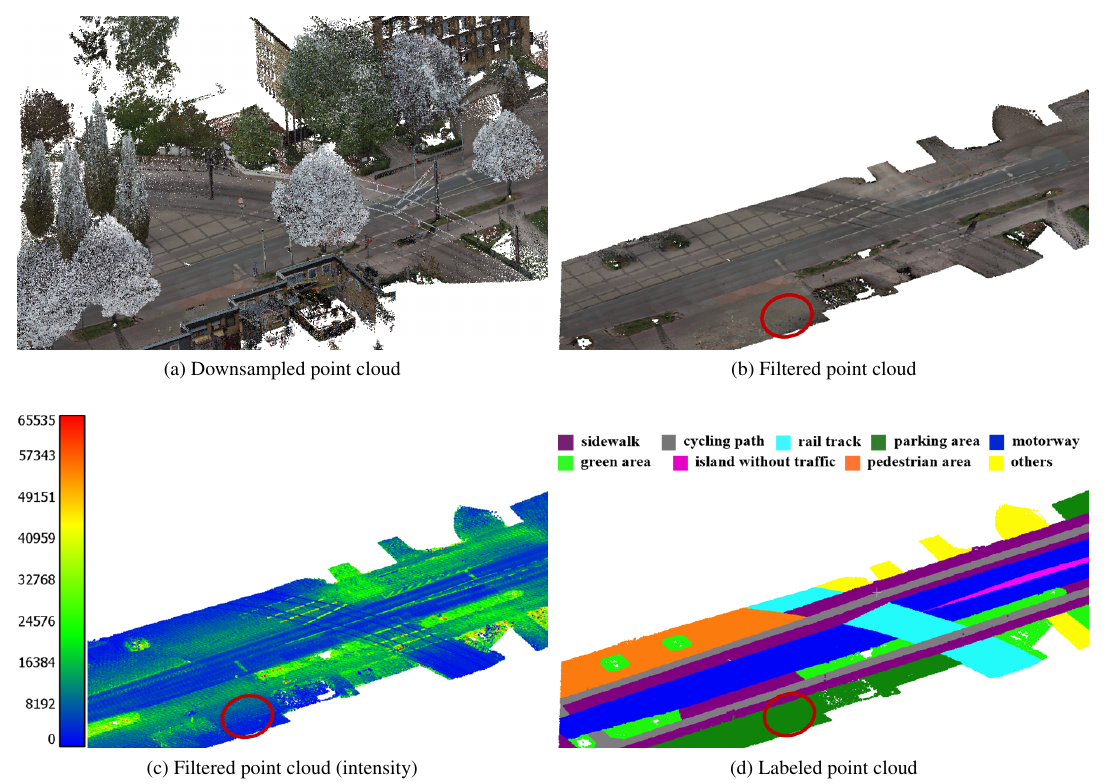
Figure 2. Downsampled, filtered and labeled point cloud. Circle areas highlight the similarity between some parking areas and sidewalks.